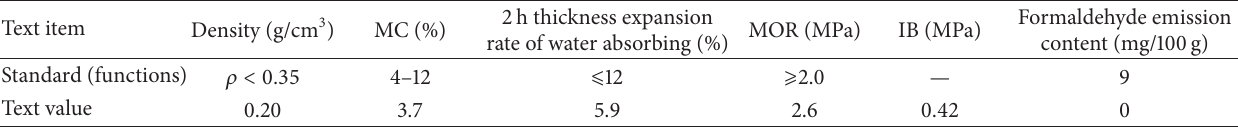
Table 1: The physical and chemical properties of the composite